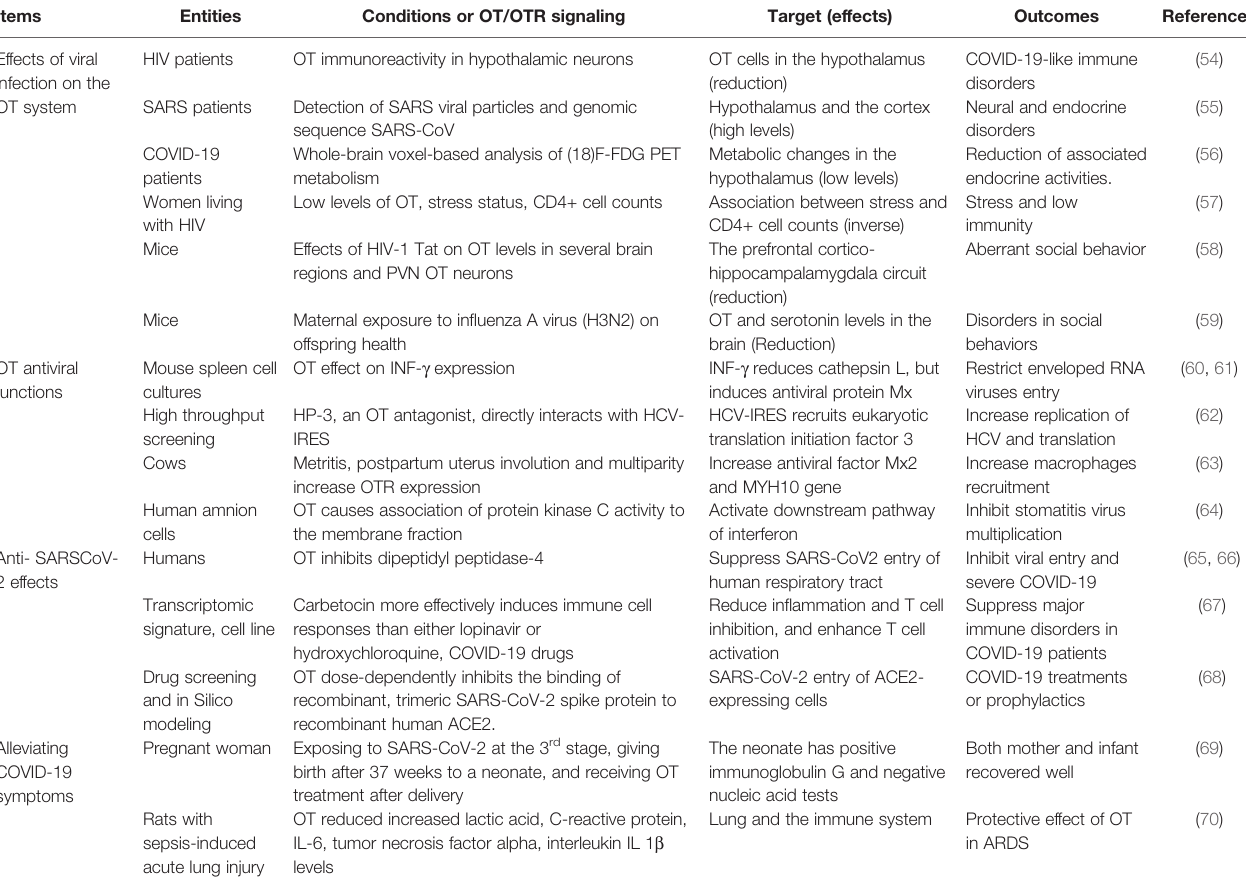
TABLE 2 | Effects of viral infection on the oxytocin system, and general antiviral properties and experimental evidence supporting oxytocin anti-COVID-19 functions.